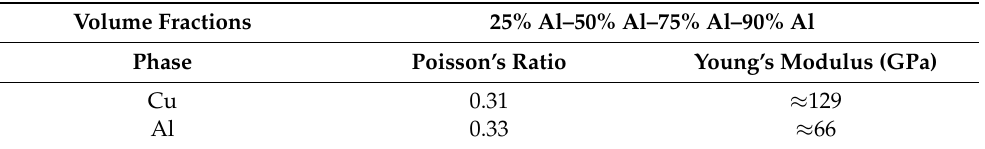
Table 2. Elastoplastic simulation parameters for investigating the development of transverse stresses in CCA